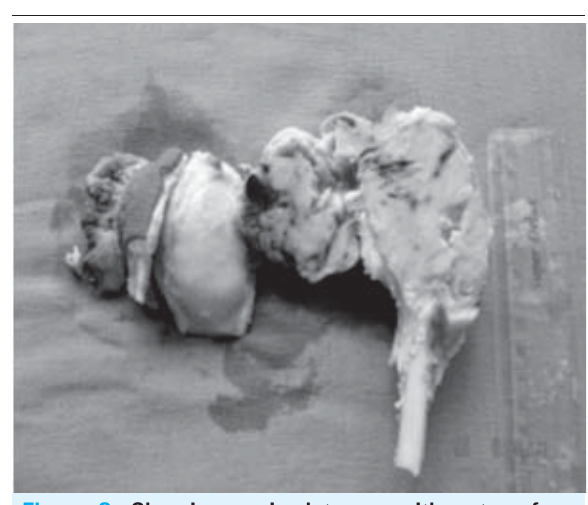
Figure 2. Showing excised tumor with cut surface fl eshy and grayish white with focal area of hemorrhage